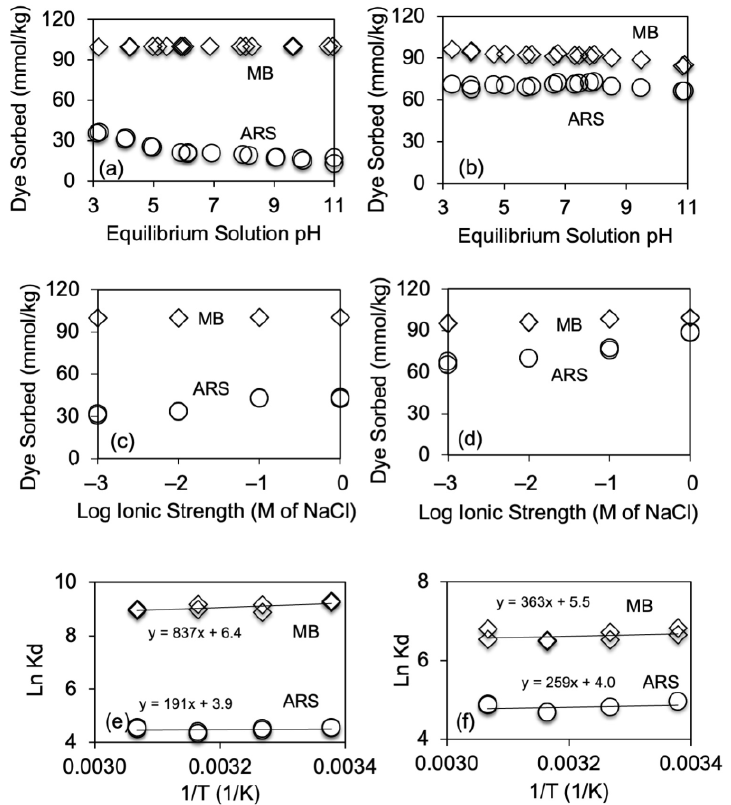
Figure 4. The influence of an equilibrium solution pH ( a , b ), ionic strength ( c , d ), and temperature ( e , f ) on ARS (circle) and MB (diamond) sorption from a single solution ( a , c , e ) and mixed solutions ( b , d , f ) on halloysite.